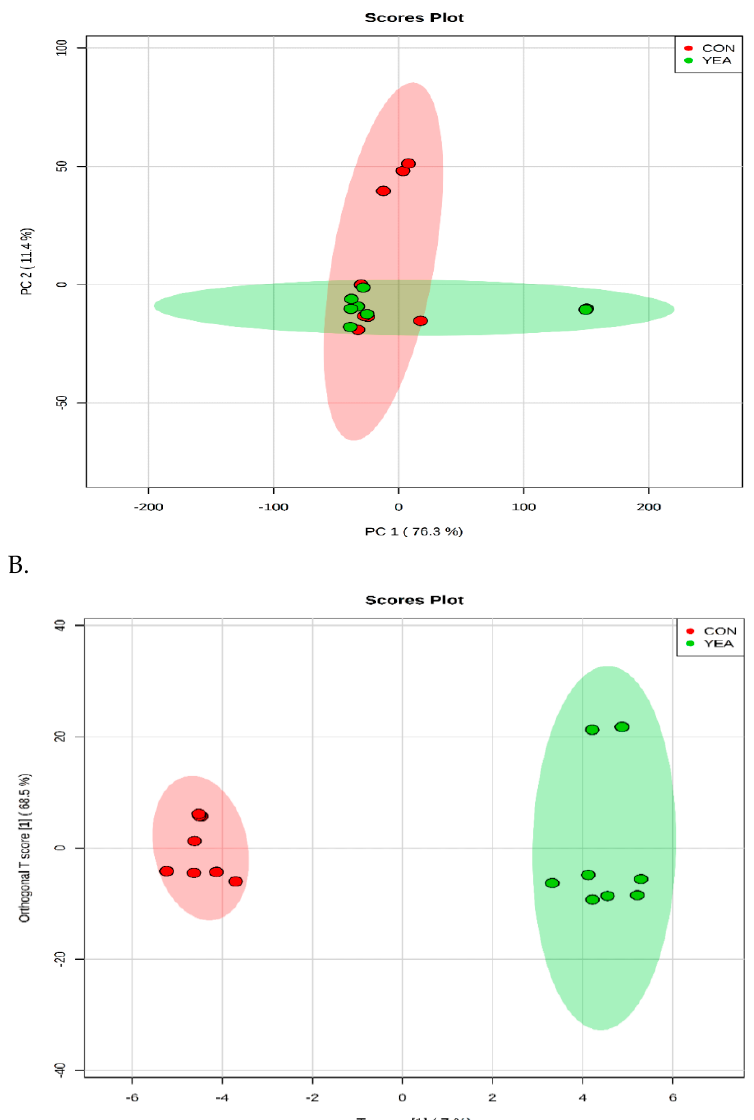
Figure 3. ( A ) The scores plot of the PCA model showing the directions that best explain the variance between the two treatments. ( B ) OPLS–DA score plot of all metabolite features. CON = steers fed control diet (no live yeast product), YEA = steers fed 15 g/d of live yeast product (PMI, Arden Hills, MN, USA). Each data point represents one rumen fluid sample.